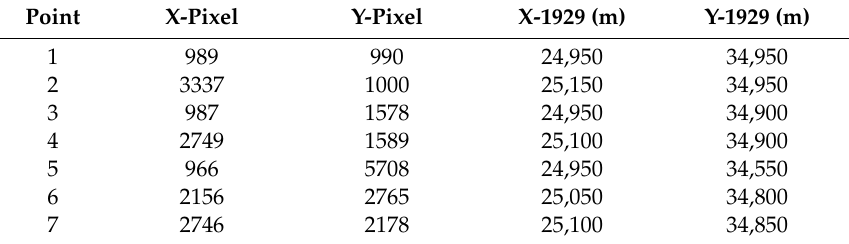
Table 1. Point coordinates in the source (pixel) and target (1929) reference systems.